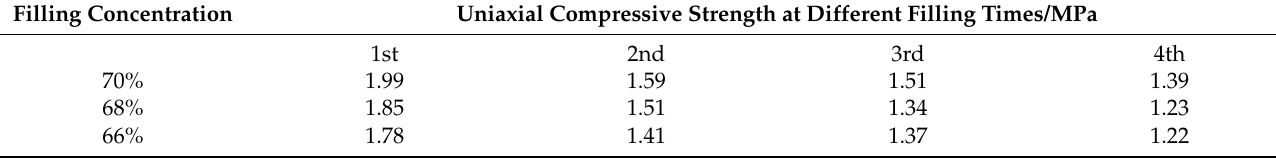
Table 4. 28-day strength of slicing